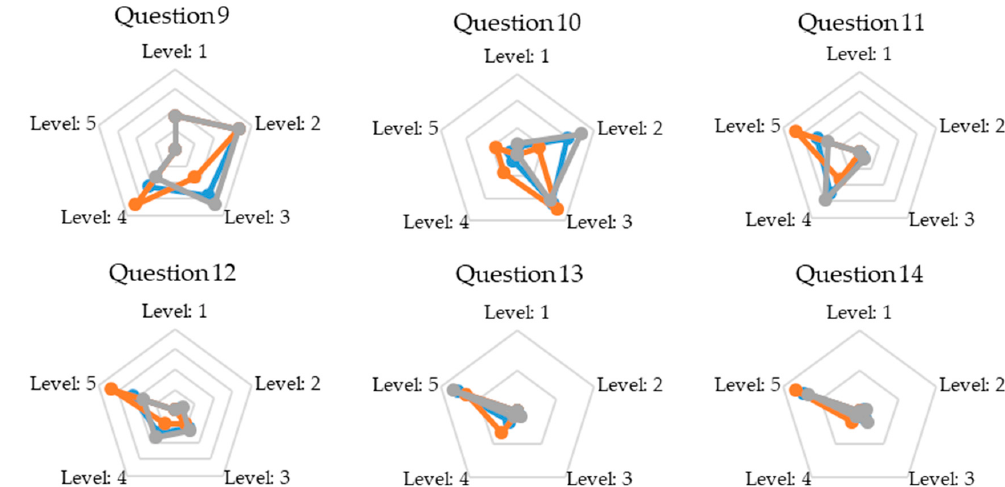
Figure 2. Radar charts showing mean responses to the 14 questions related to the STS for three subject groups: total, female, and male. Levels 1 to 5 refer to the five-level scales used for each question (e.g., 1 = strongly disagree and 5 = strongly agree).